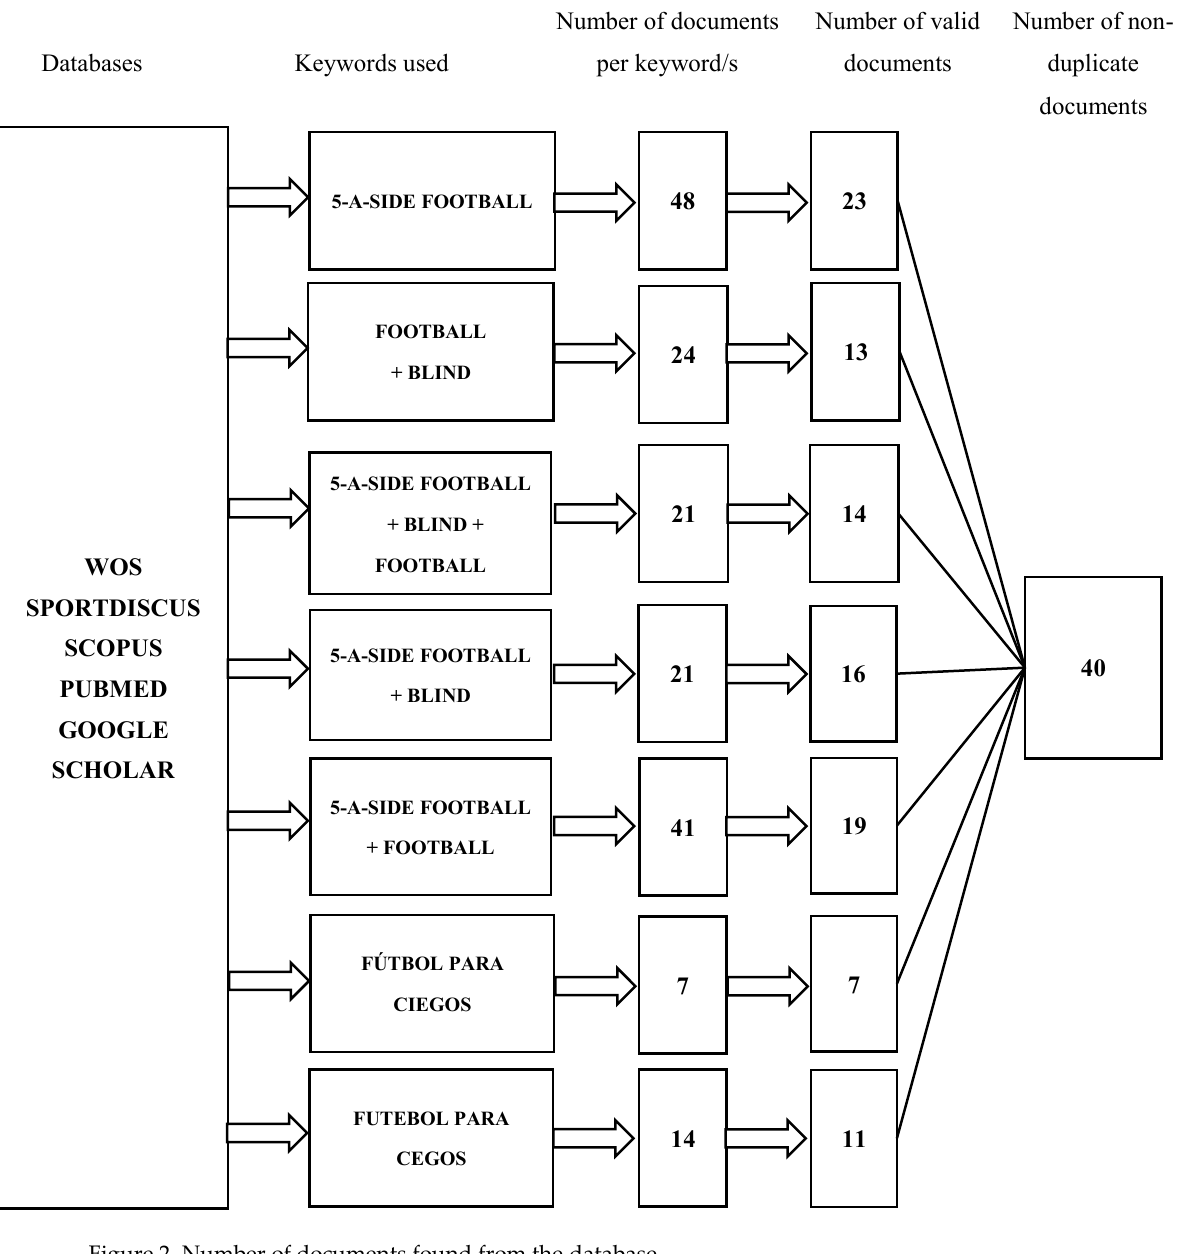
Figure 2. Number of documents found from the database Access to